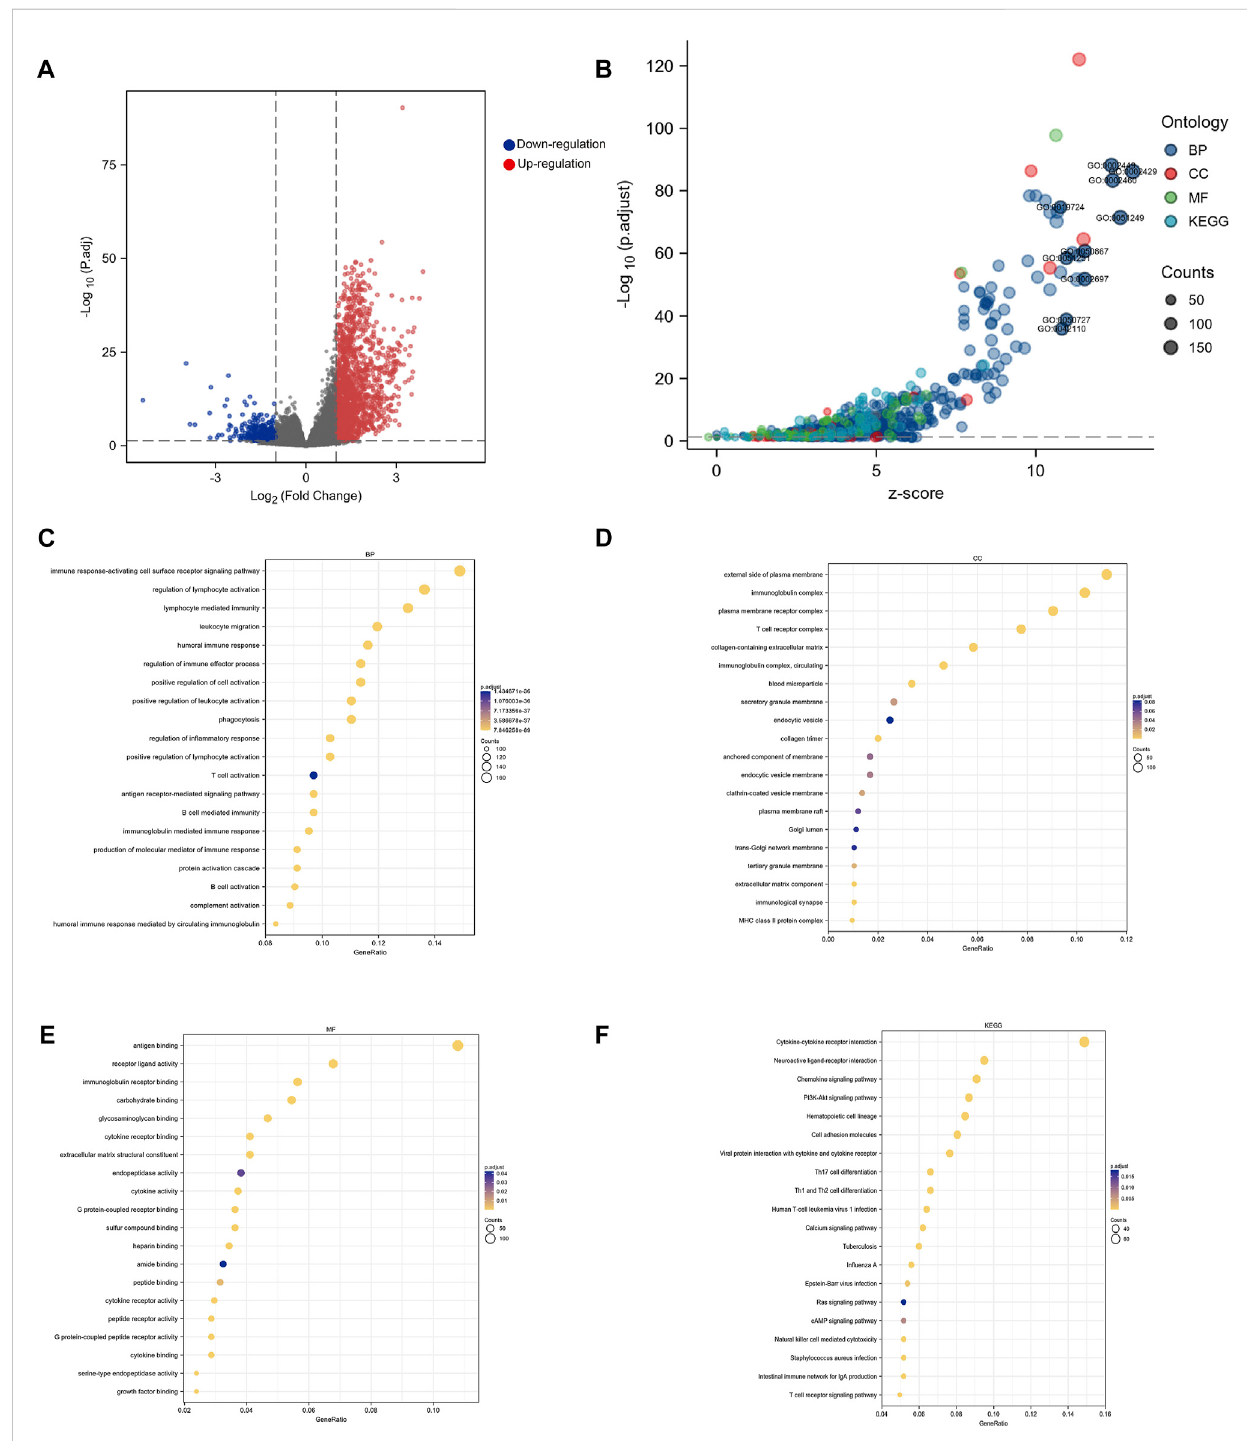
FIGURE 4 Biological function analysis of KLF4 (A) Volcano map of DEGs related to KLF4 in HCC (B) Go analysis and KEGG pathway enrichment of DEGs (C – F) Signi fi cant analysis for the BP, CC, MF and KEGG, respectively. BP, biological process; CC, cellular compartment; MF, molecular functions.